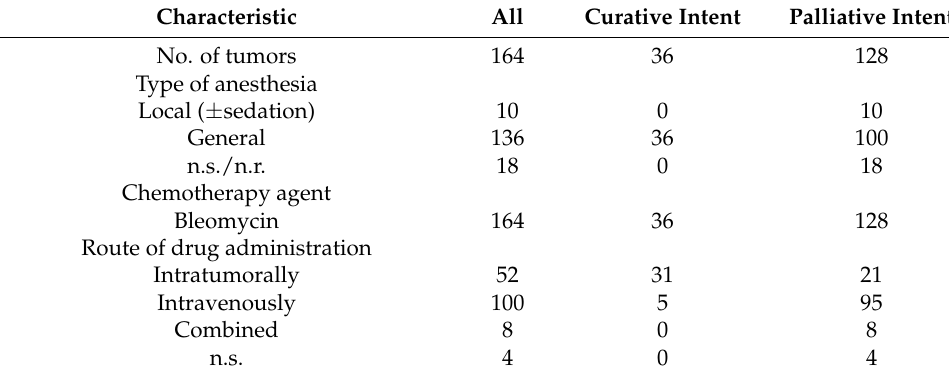
Table 3. Characteristics of the electrochemotherapy